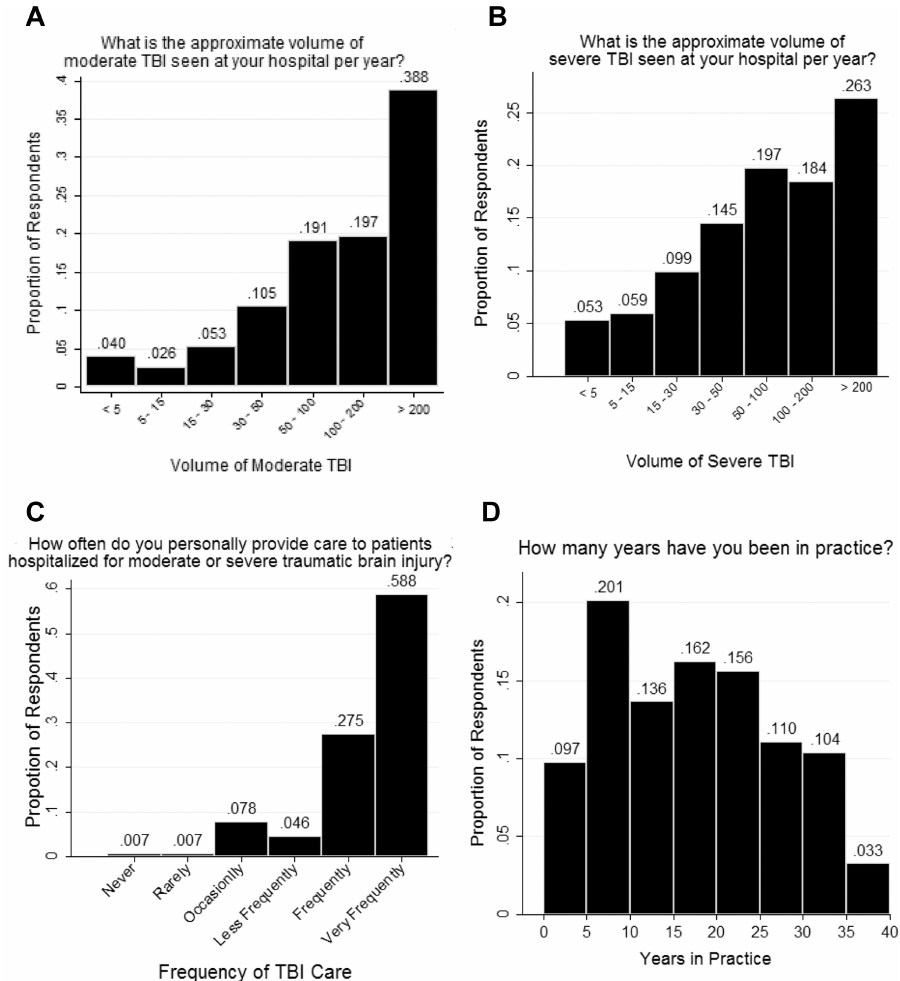
Fig 1. Responses to survey questions 7, 6, 8, and 2 (S1 Survey, Supplemental Digital Content 1) are presented in A, B, C, and D, respectively. A) Reportedvolume of moderate TBI cared for at the respondents’ institutions per year. B) Reportedvolume of severe TBIs cared for at the respondents’ institutions per year. C) Reportedfrequencyof individualneurotrauma physiciansprovidingTBI care. D) Years in practice for survey